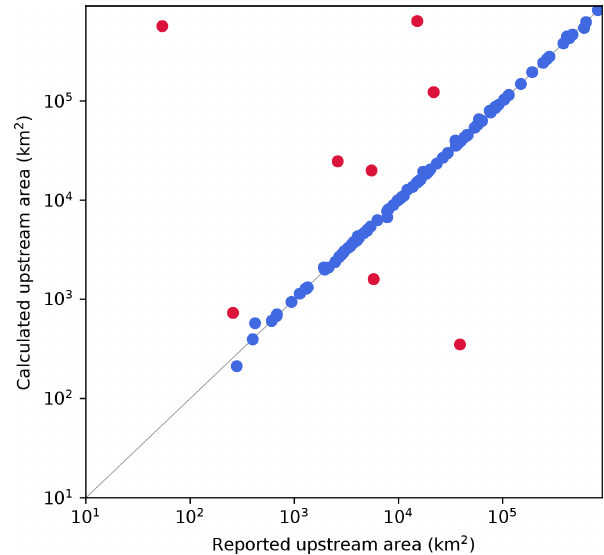
Figure 3. Comparison between calculated upstream area (km 2 ) in the river–lake network developed in this study (vertical) and re- ported values registered in GRanD (horizontal). Red dots indicate the reservoirs whose areas (km 2 ) differ by more than a factor of 2 or 0.5 as listed in Table